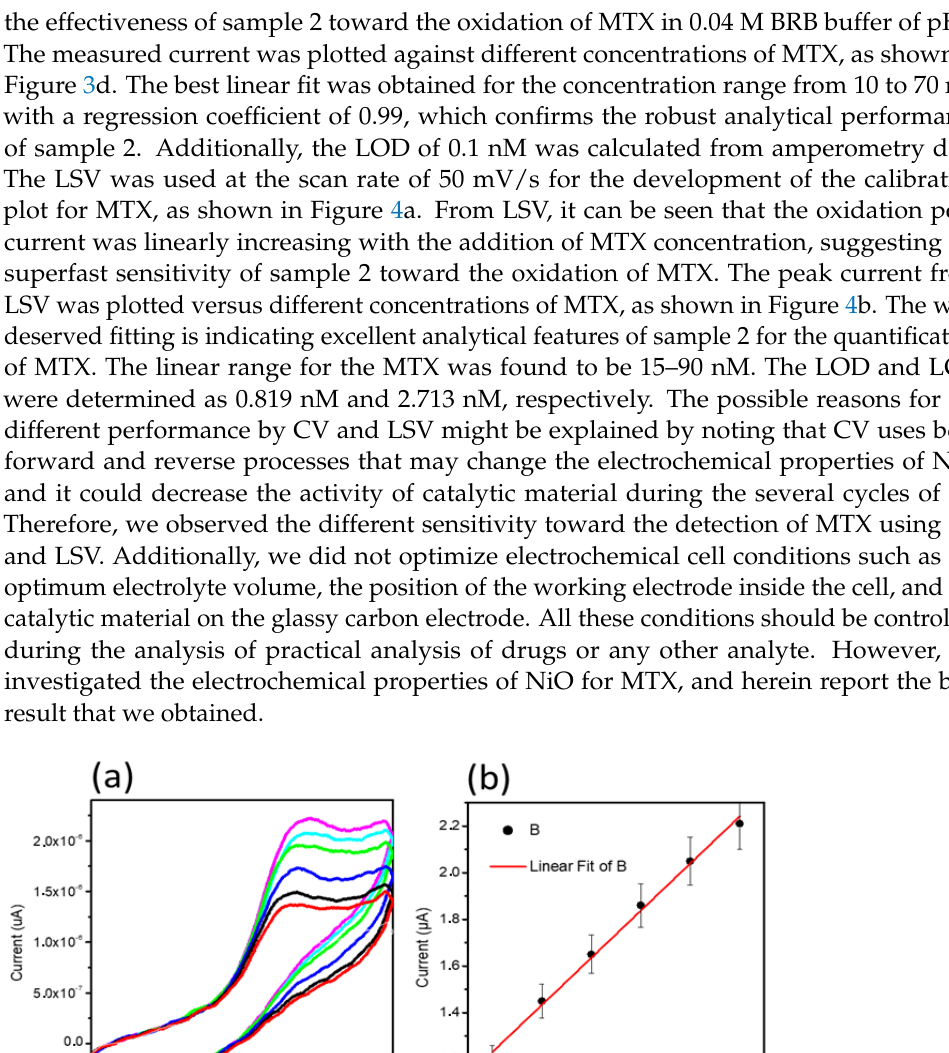
Figure 3. ( a ) CV curves recorded at a sweeping rate of 50 mV/s for sample 2 at various concentrations of MTX ranging from 5 to 30 nM in a 0.04 M BRB buffer of pH 2, ( b ) A plot of peak current against different concentrations of MTX from 5 to 30 nM, ( c ) i–t curve at the oxidation potential of 0.95 V MTX with the addition of 10 nM MTX, and ( d ) a fitting of increasing current versus various concentrations of